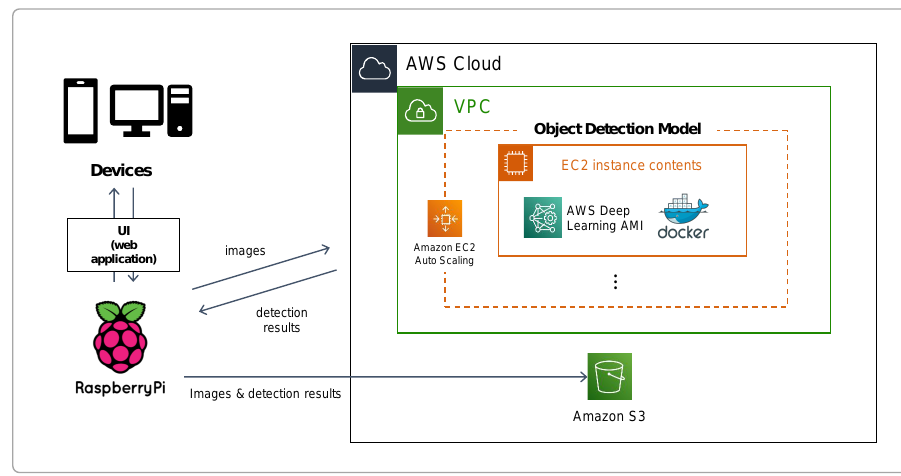
Figure 4. Object-detection server architecture based on AWS development